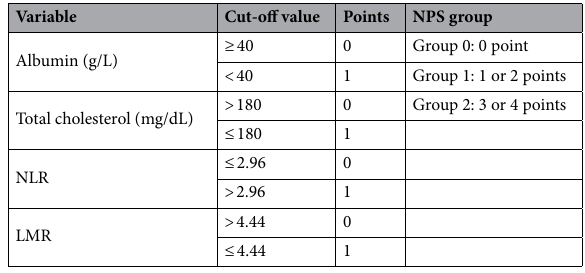
Table 1. Calculation of the NPS. LMR lymphocyte-to-monocyte ratio, NLR neutrophil-to-lymphocyte ratio, NPS Naples prognostic